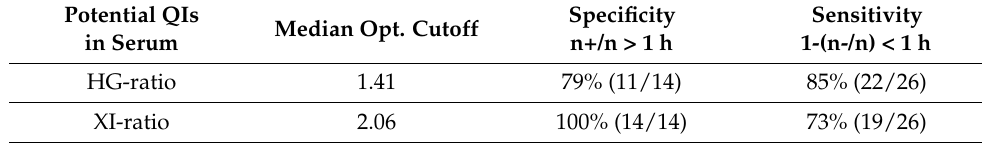
Table 3. Proposed QIs to be considered for further investigation in serum and EDTA